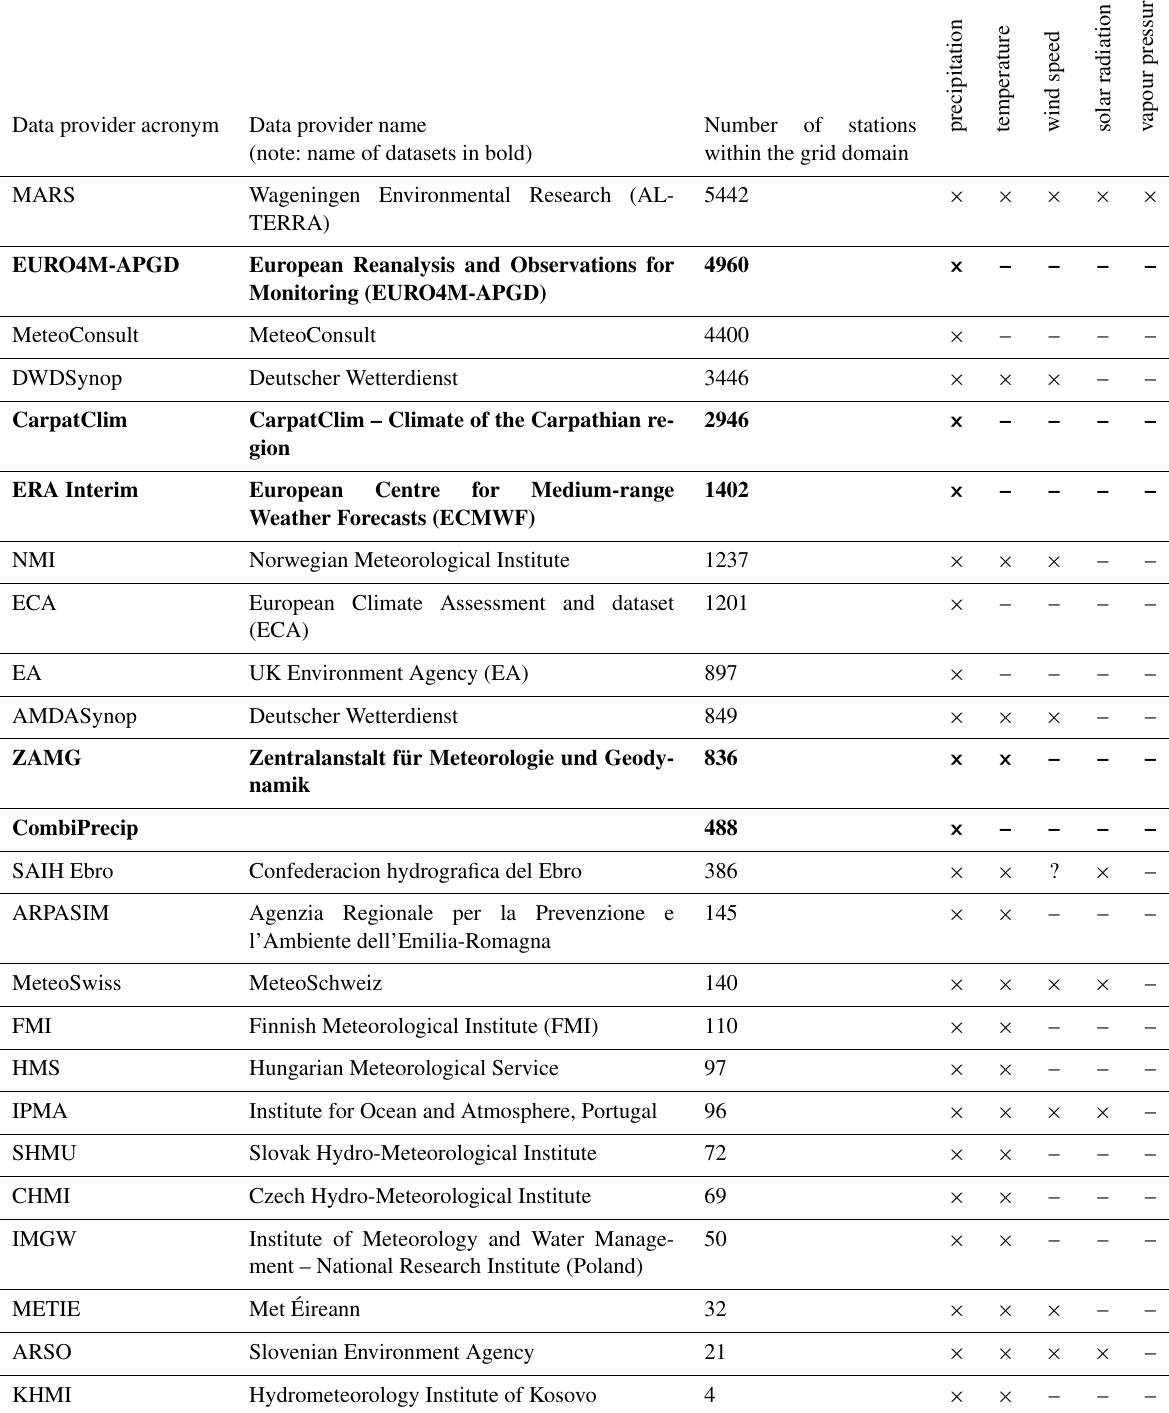
Table 1. EMO-5 data provider (in bold the providers of gridded data).